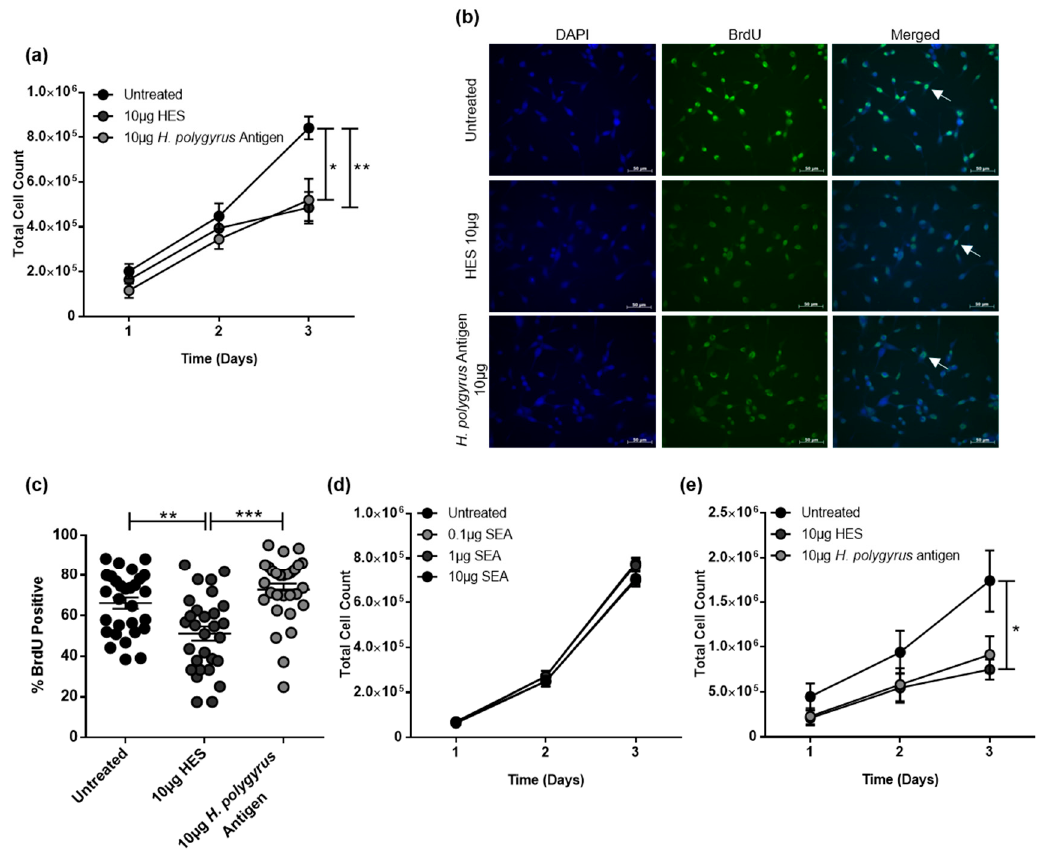
Figure 1. H. polygyrus -derived antigens limit colorectal cancer (CRC) cell proliferation. Live cell counts over a 3-day period of ( a ) CT26.WT and (e) HCT116 cells, following exposure to 10 μ g H. polygyrus